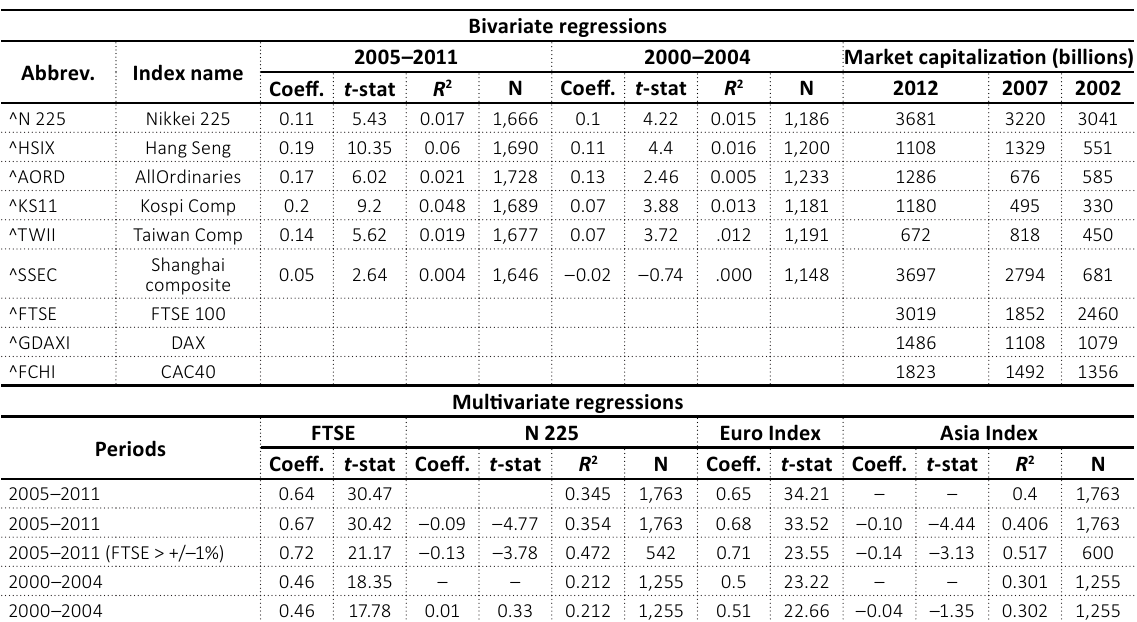
Table 4. Regression coefficients (or betas) for regressing the S&P 500 index daily returns on